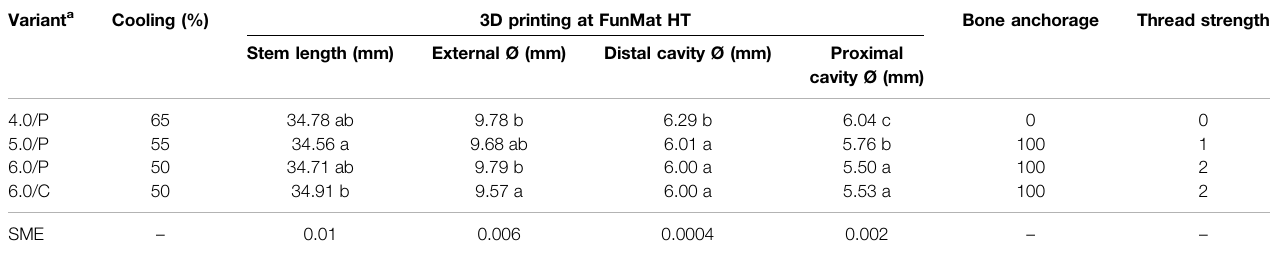
TABLE 6 | 3D-printed (FunMat) tibiae PEEK-plug dimensions and their corresponding bone anchorage and thread strength values. Variant a Cooling (%) 3D printing at FunMat HT